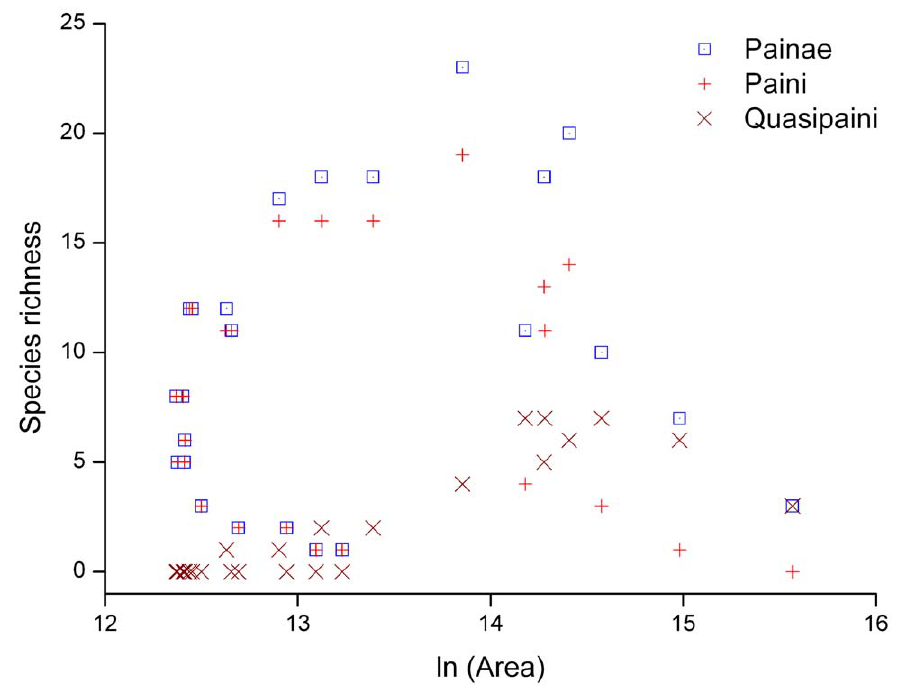
Figure 4. Scatter plots showing the relationship between species richness of spiny frogs and area. The relationship is shown for the subfamily Painae and the tribes Paini and Quasipaini respectively.